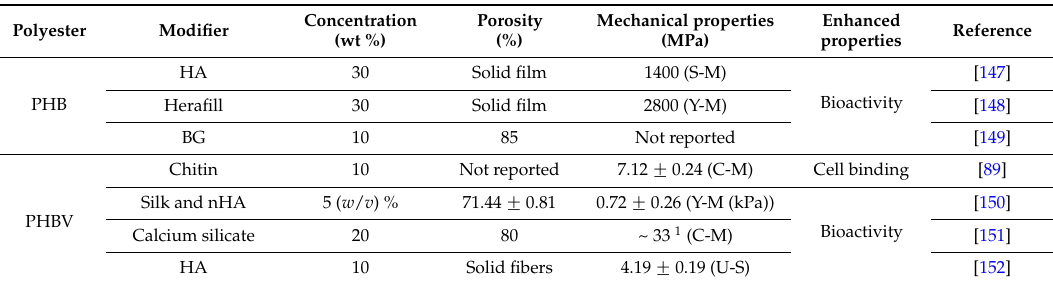
Table 5. The physicochemical modifications of the polyhydroxyalkanoates (PHA)-based polyesters in the field of biomedical and tissue